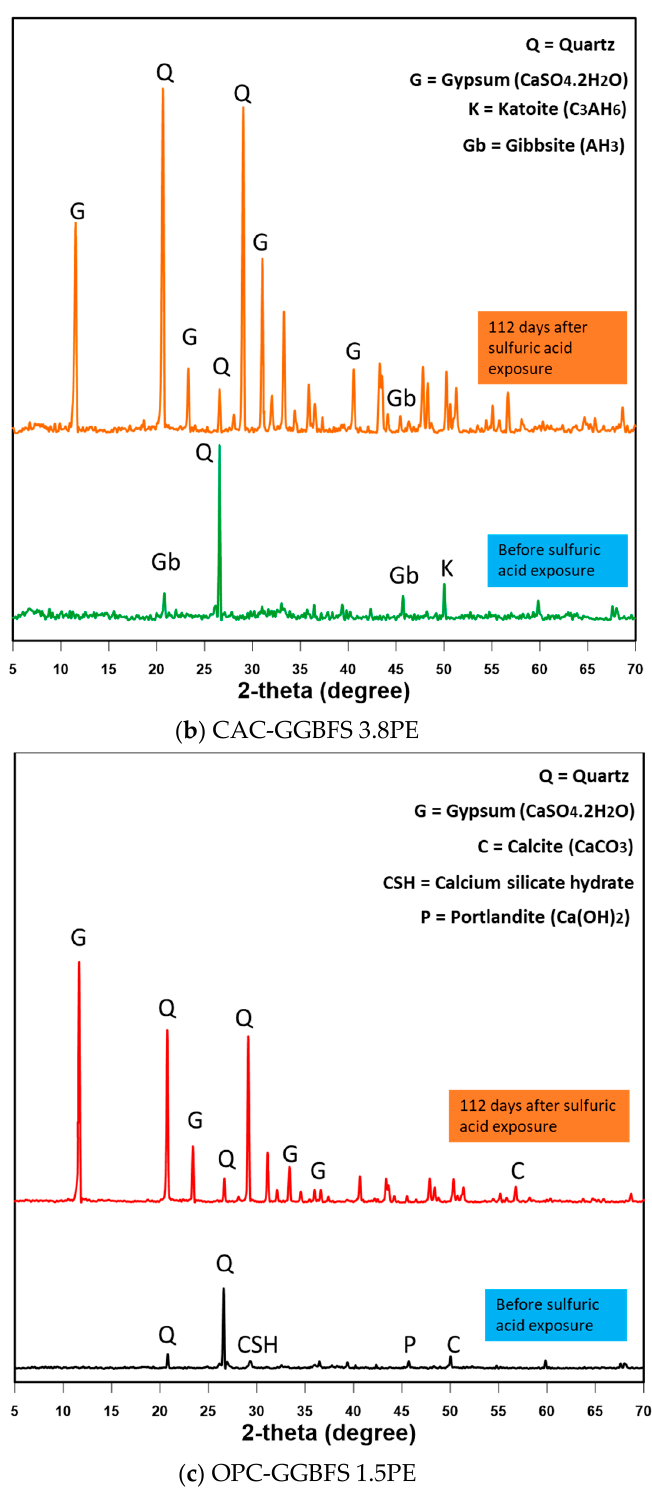
Figure 8. XRD analysis on fibre reinforced CAC/OPC-GGBFS blended mortar